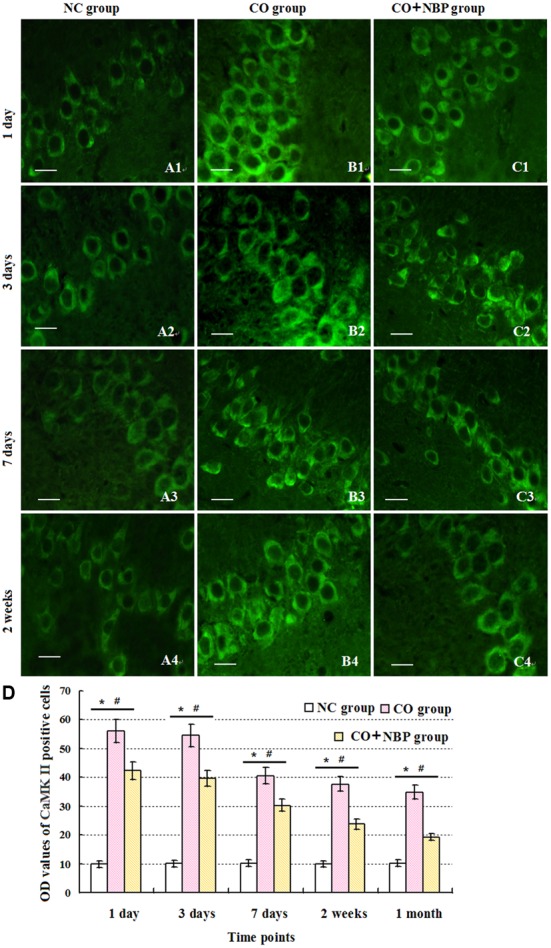
Alterations of CamK II positive cells in each group. CaMK II positive cells were observed in rats in NC group (A1–A4), while the amount of CaMK II positive cells in CO poisoning individuals was sharply increased to the peak between days 1 and 3 with strong fluorescent values, and then decreased (B1–B4). Nevertheless, it was still higher than that of NC group till 1 month (n = 4, P < 0.05). NBP administration could down-regulate the expression level of CamK II compared with that in CO group at the same times (C1–C4; n = 4, P < 0.05). (D) Histogram of the OD values of CaMK II positive cells in each group at different time points. ∗Compared with NC group (n = 4, P < 0.05); #compared with CO group (n = 4, P < 0.05). F = 10.941∼22.437. Scale bar is 30 μm.